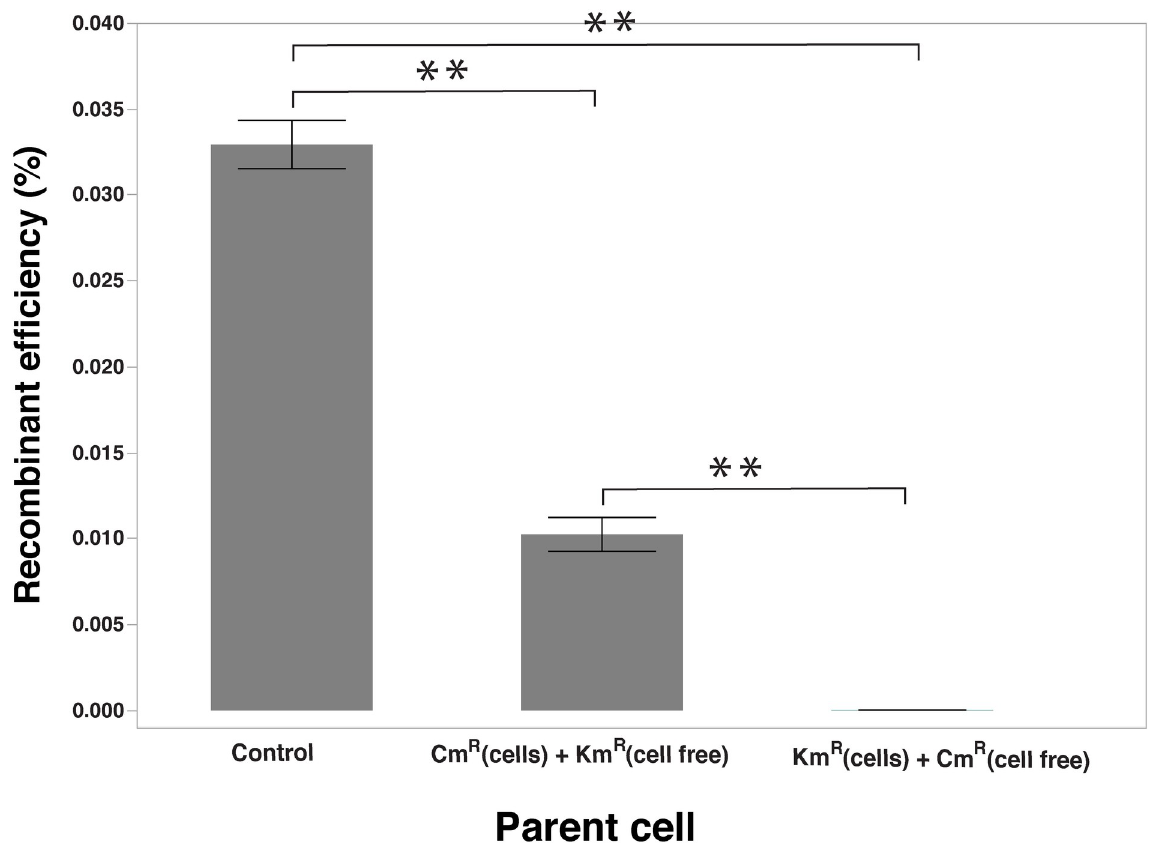
Fig 8. Changes in the recombinant levels when a parent cell is replaced by its cell-free supernatant. The recombinant levels were compared between the standard recombination assay and the modified assay in which one out of two marker cells is replaced by its cell-free supernatant. Recombinant levels expressed as percentage recombinants in the total number of parent cells; �� indicates a significant difference at P < 0.01.